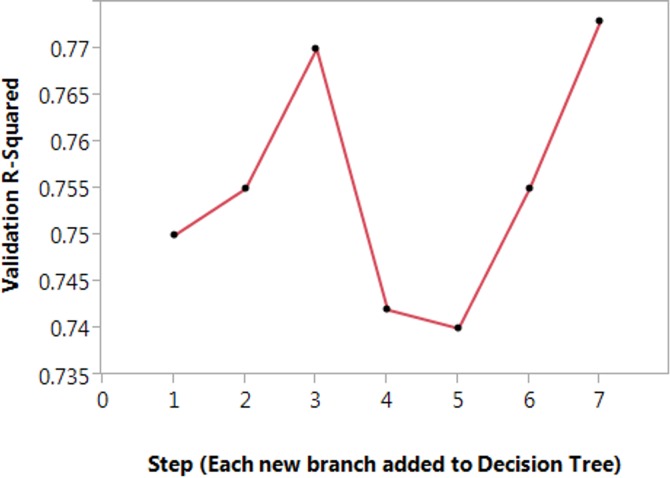
Tracking the coefficient of determination as the DTL model is built.A line plot of the R-squared for each branch added at each step in the generation of the decision tree learning model. The prediction is the cell survival (a continuous variable) after cryopreservation.